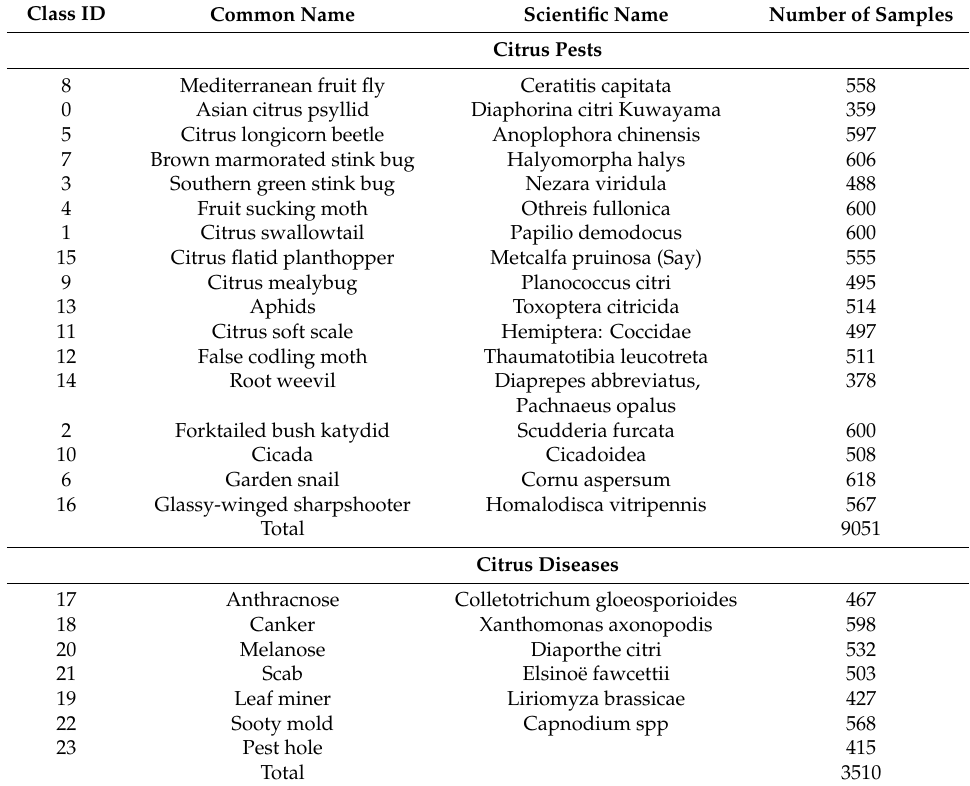
Table 1. The description of citrus pests and diseases image